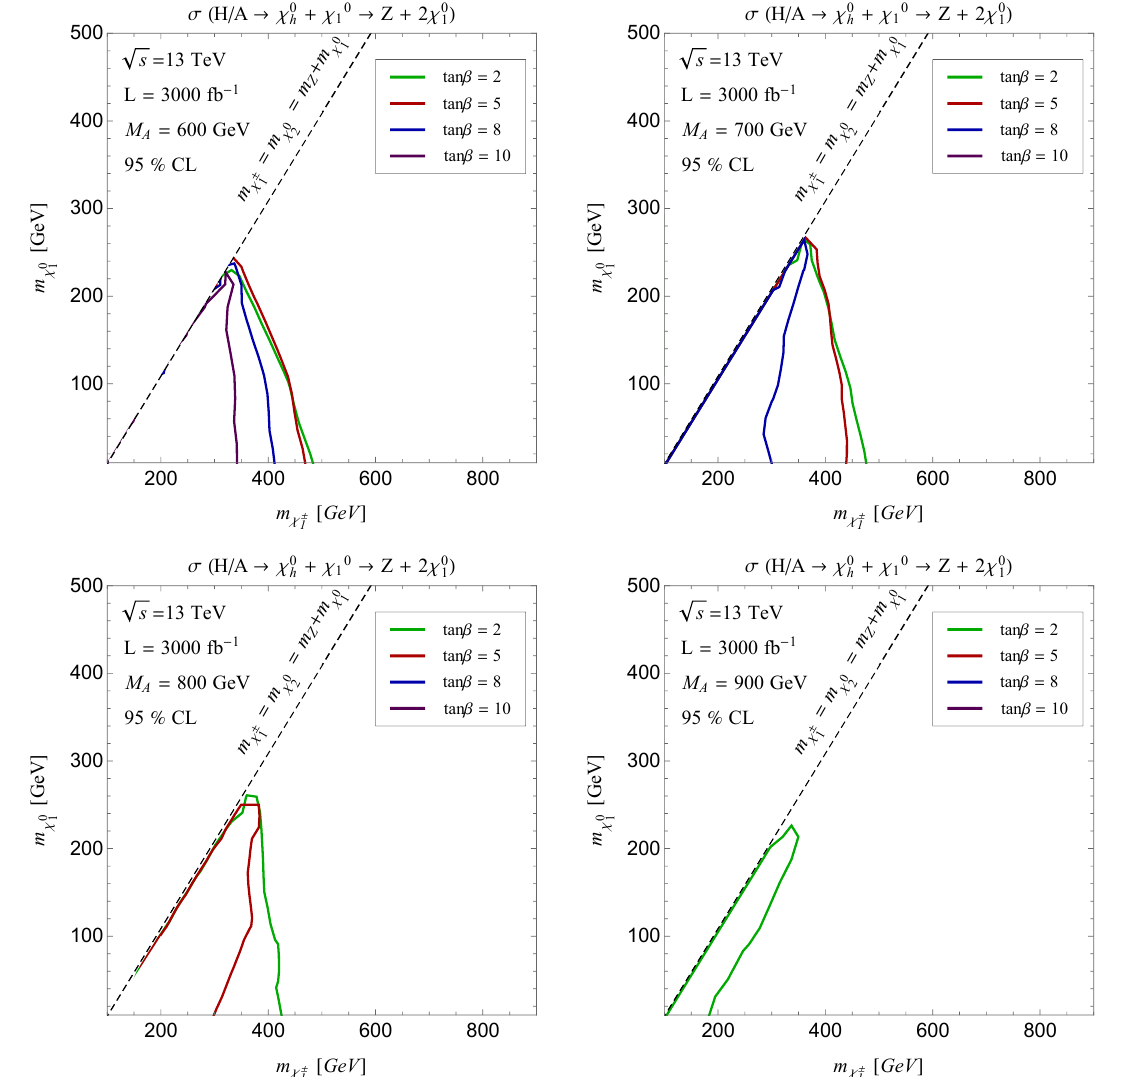
Figure 7 . 95 % CL bounds on the heavy neutral Higgs decay into electroweakinos H=A (cid:31) 0 (cid:31) 0 Z + 2 (cid:31) 0 , with Z ‘ + ‘ (cid:0) . With integrated luminosity of 3000 fb (cid:0) 1 and m 1 ! 1 h ! 600 ; 700 ; 800 ; 900 GeV, the sensitivities for electroweakinos are shown as contours in the m plane for tan (cid:12) = 2 (cid:0)